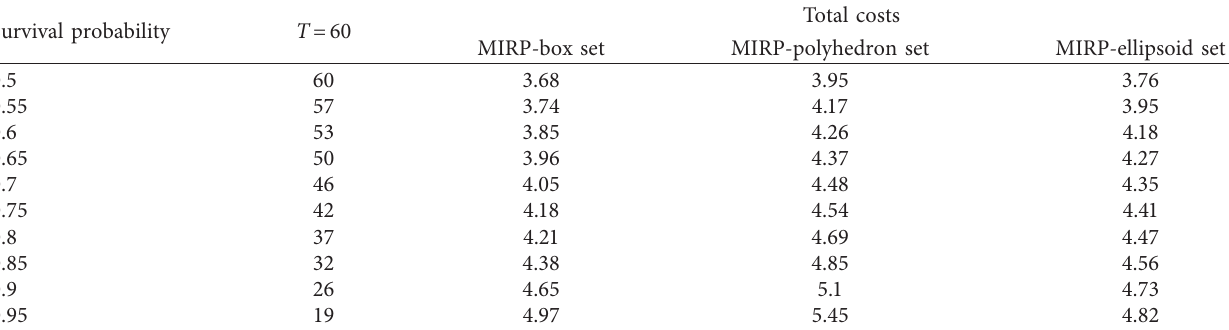
Table 10: Total costs at different survival probability times.